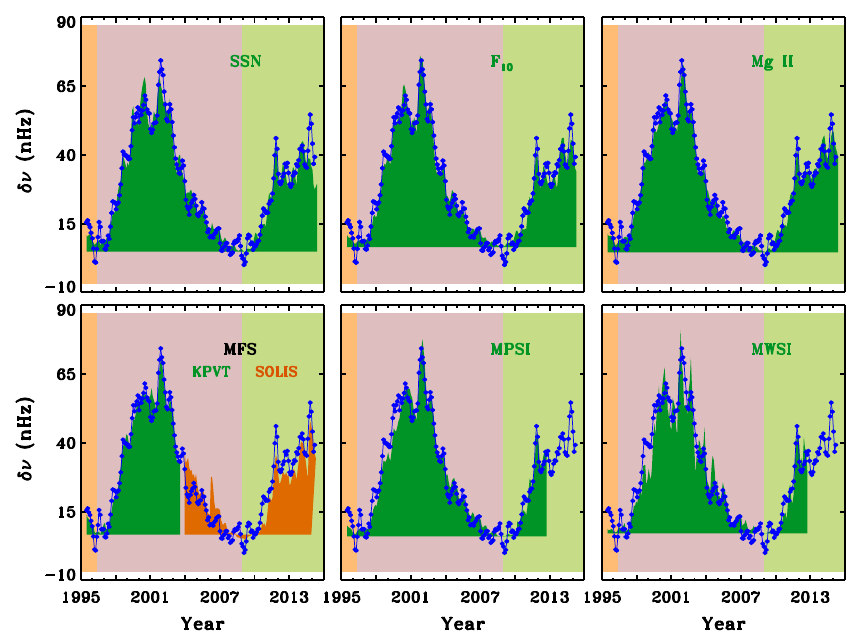
Fig. 28 The time-evolution of the GONG frequency shifts ( points ) plotted with different activity proxies ( filled regions ) scaled to fit on the same axis. The frequency shifts were calculated with respect to the temporal mean of the frequencies. The orange , pink and light-green backgrounds denote solar cycles 22, 23 and 24 respectively. Figure courtesy of Kiran